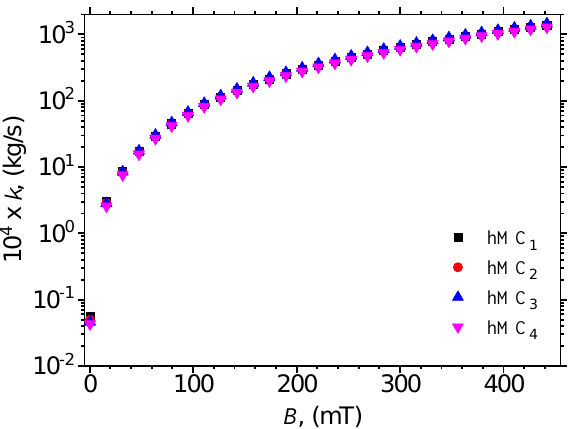
Figure 12. Variation of the particle friction coefficient k of the particles inside hMCs, with the magnetic flux density B